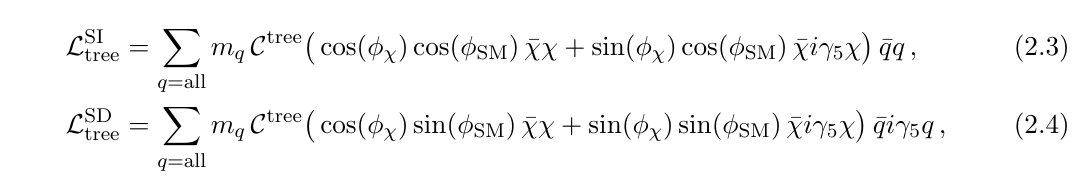
Figure 1 . Tree-level, Higgs-induced triangle as well as box diagram contribution to the cross section relevant for direct searches of DM. All Feynman diagrams are drawn with TikZ-Feynman [53]. we